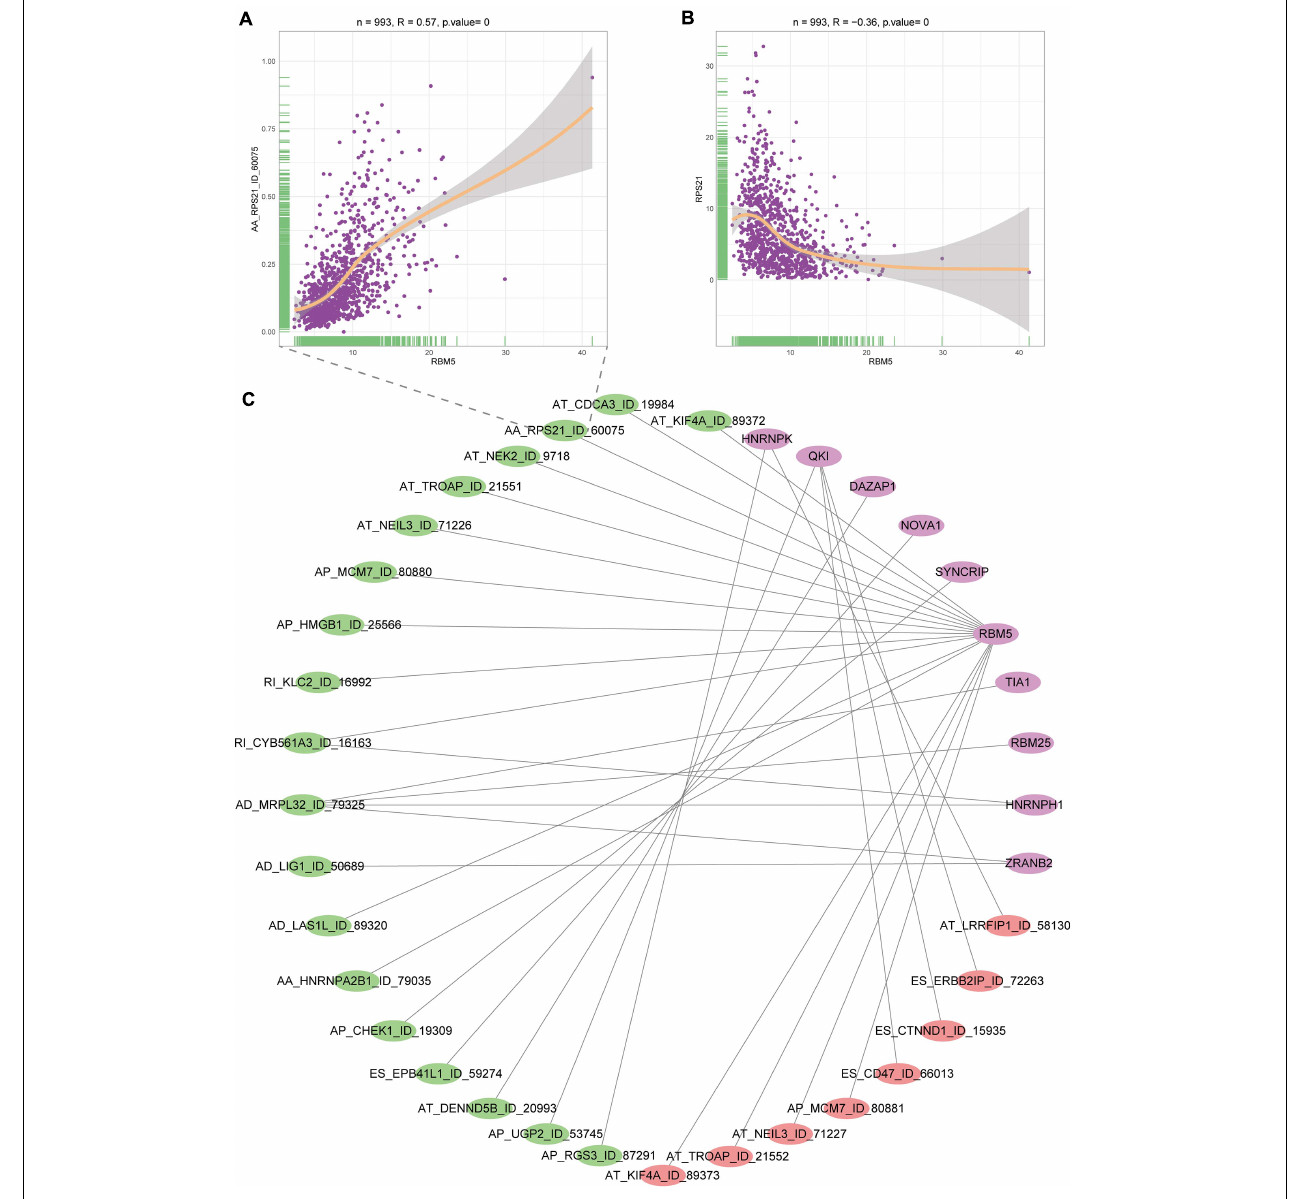
FIGURE 4 | Interaction diagram between SFs and DEAS events. (A) Correlation diagram of the SF named RBMS and alternate splicing event of RPS21. (B) Correlation diagram of the SF named RBMS and parent gene expression of RPS21. (C) Network between SFs and AS events. Purple represents SFs, green represents positive correlation, and red represents negative